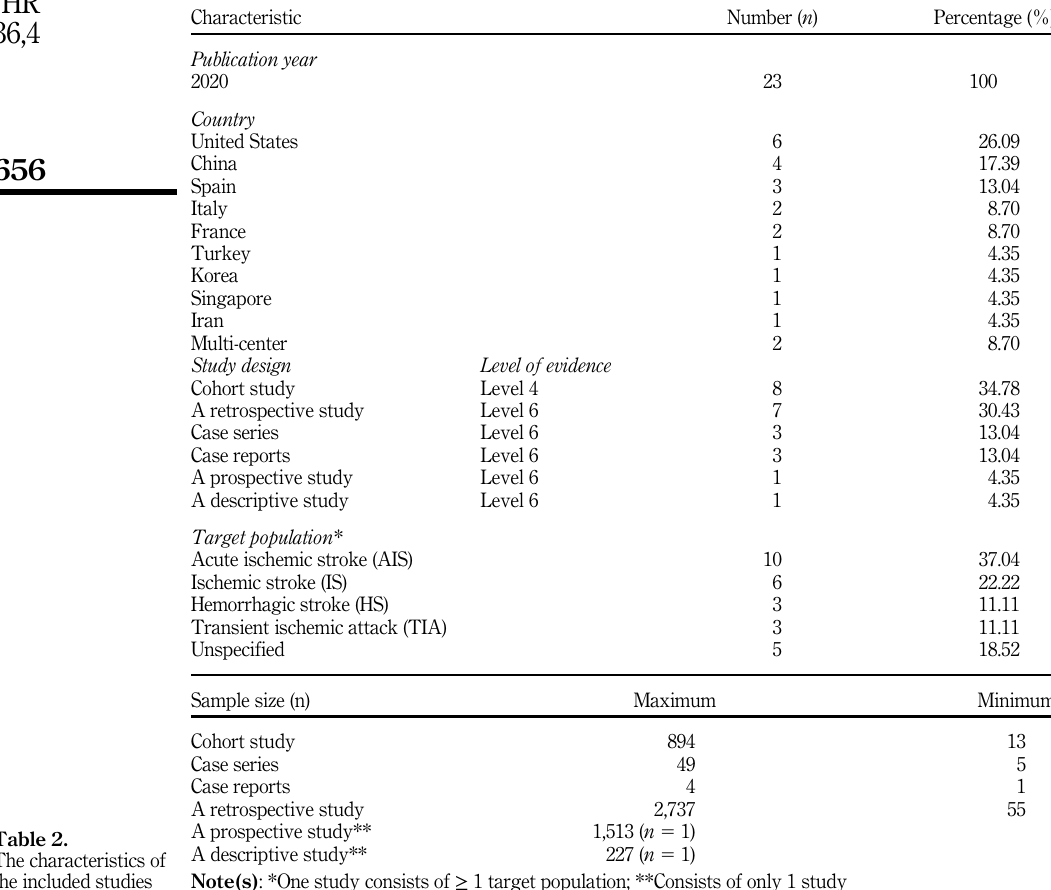
Table 2. The characteristics